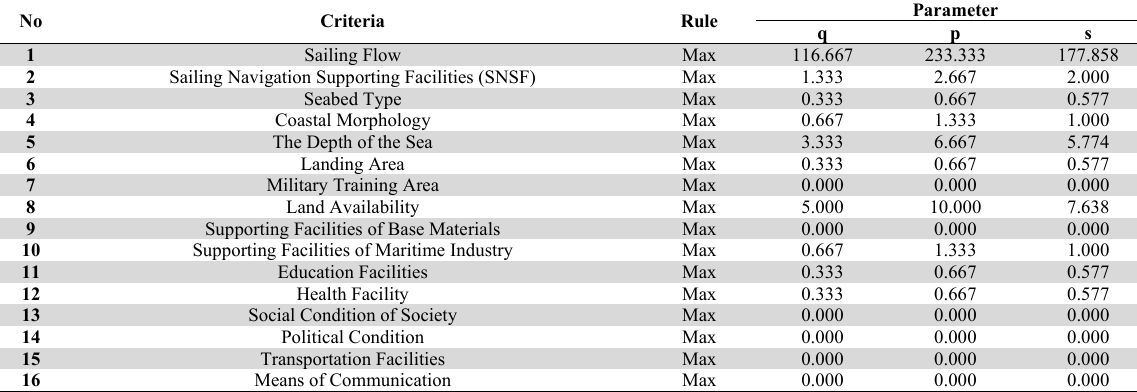
The threshold value of the criteria No Sailing Navigation Supporting Facilities (SNSF)